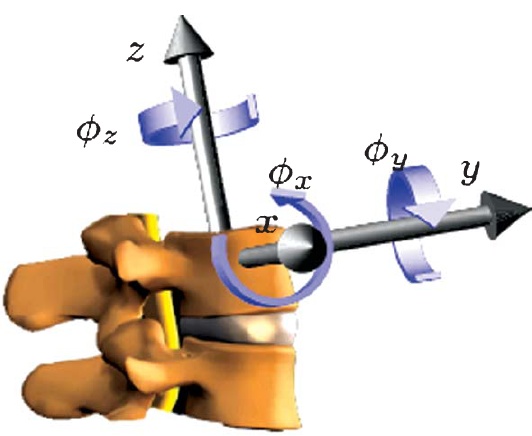
Fig. 4. Basic motions of a spine, [4].